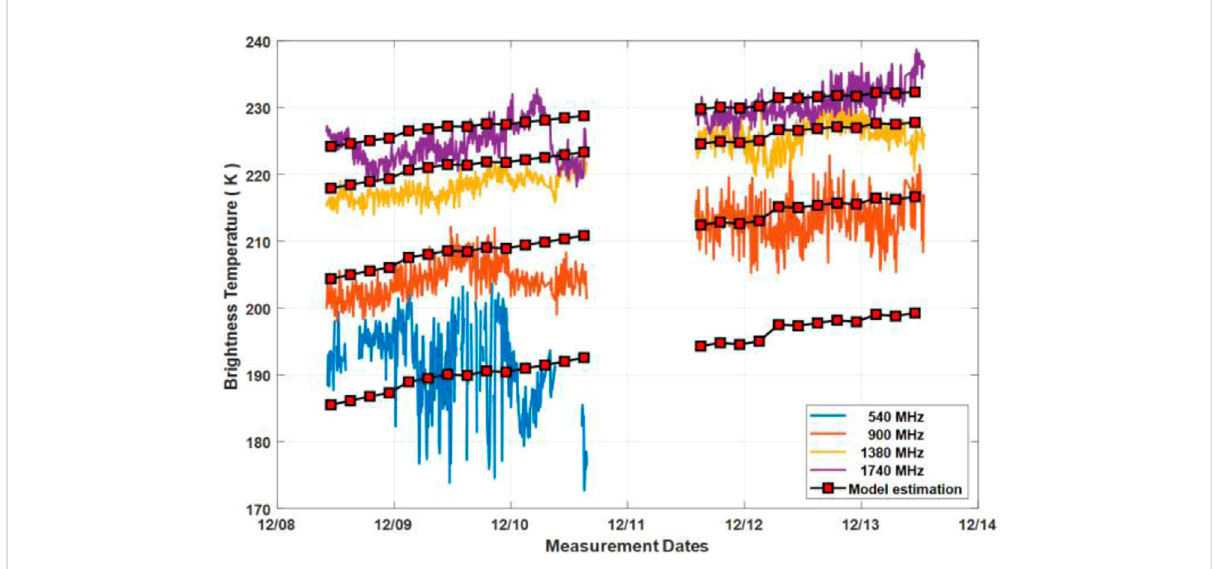
FIGURE 11 T B forthefour-channel,modi fi edUWBRADinstrumentoperatedonathickmultiyearice fl oeinDecember2019.Modelestimateshowsthatthe slow accretion of new sea ice at the base gradually increases the brightness temperature at all frequencies (From Demir et al.,